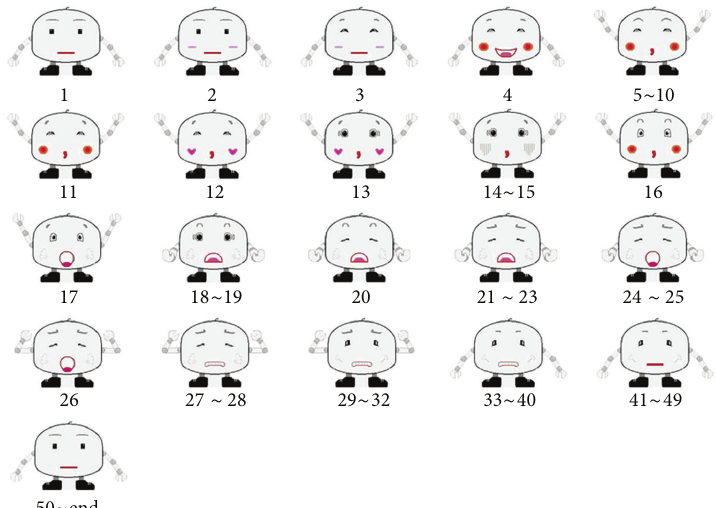
Figure 7: The emotional expressions based on emotions generated by young males.